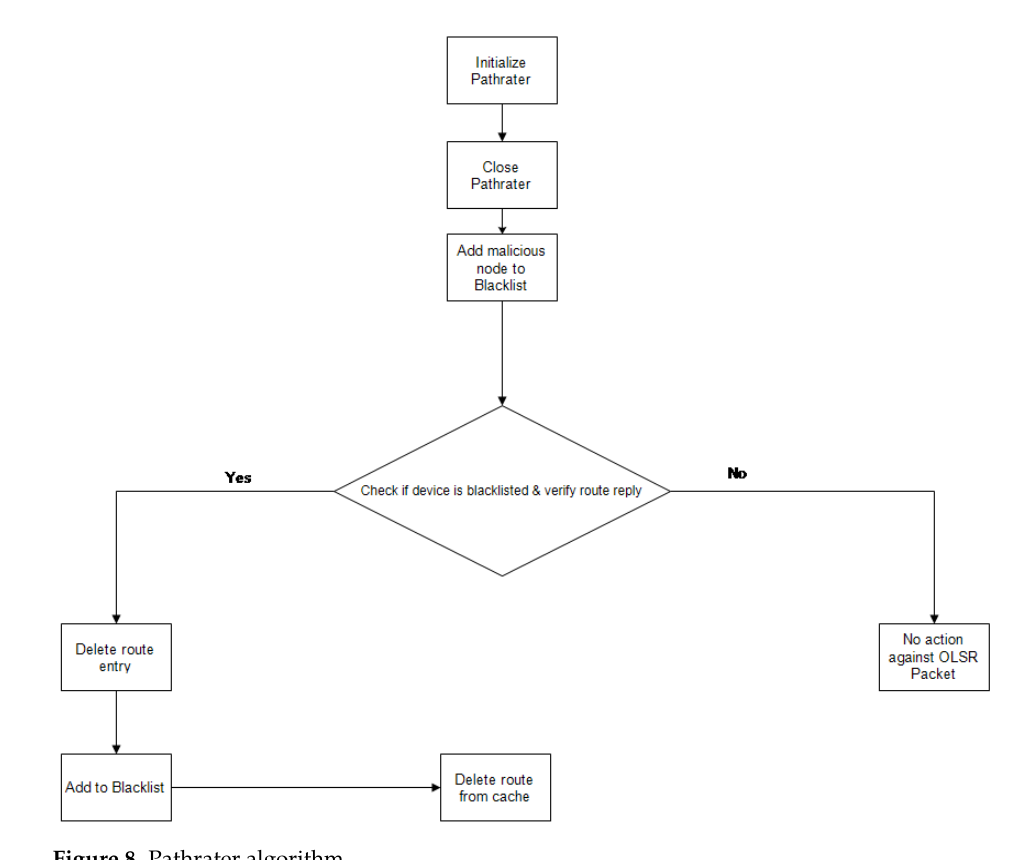
Figure 8. Pathrater algorithm.